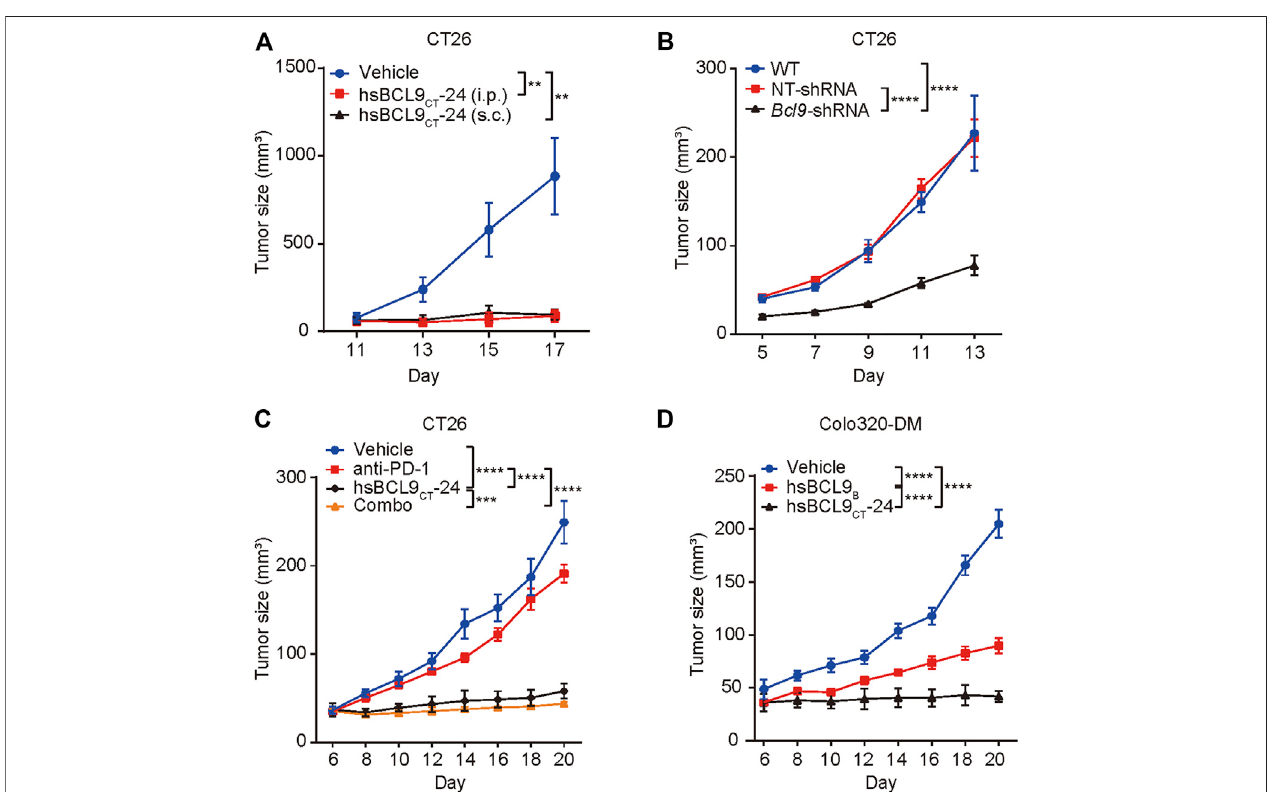
FIGURE1| Theeffectofbcl9inhibitorsontumorgrowth. (A) BALB/cmicewereinoculatedwithCT26cells via single fl ankimplantationandtreatedwithhsBCL9 CT - 24 (ip., 25 mg/kg, QD) or hsBCL9 CT -24 (sc.,30 mg/kg, QD) as indicated after tumor volume reached 30 mm 3 ( n (cid:2) 4 per cohort). (B) CT26 cells which were transduced with NT-shRNA or Bcl9 -shRNA were inoculated in BALB/c mice ( n (cid:2) 5 per cohort). (C) Combination treatment of hsBCL9 CT -24 and anti – PD-1 Ab resulted in almost complete regression in the CT26 model. BALB/c mice were inoculated with CT26 cells via single fl ank implantation and treated with hsBCL9 CT -24 (ip., 25 mg/kg, QD), anti – PD-1 Ab [ip.,10 mg/kg, twice weekly (BIW)], and hsBCL9 CT -24 + anti – PD-1 Ab as indicated after tumor volume reached 30 mm 3 ( n (cid:2) 4 per cohort). (D) Colo320-DM cells were inoculated in BALB/c nude mice before treatment with vehicle control or hsBCL9 CT -24 (ip.,15 mg/kg, QD) as indicated after tumor volume reached 30 mm 3 ( n (cid:2) 4 per cohort). Signi fi cance were tested by 2-way ANOVA for experiments performed in triplicate, and each experiment was repeated three times, ** p ≤ 0.01, *** p ≤ 0.001, **** p ≤ 0.0001.